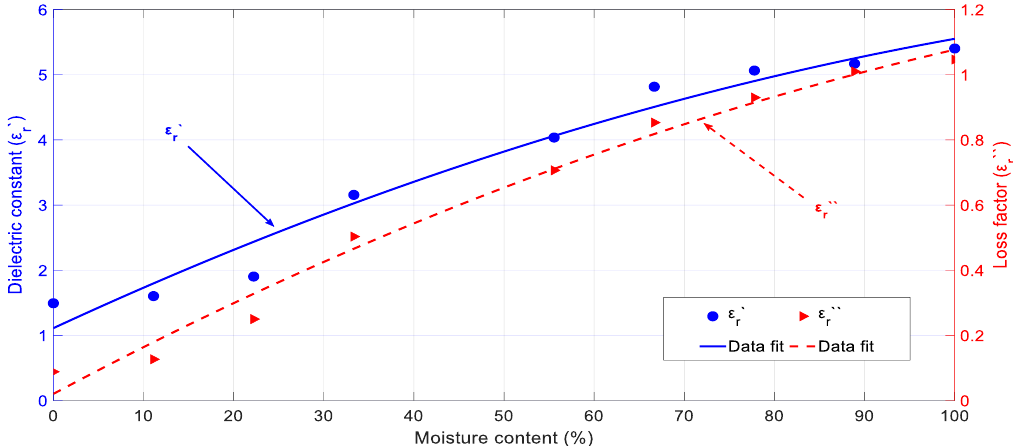
Figure 5. Dielectric properties of cypress biomass depending on the dry-basis moisture content for a 0.43 g/cm 3 initial density and room temperature (28 °C).